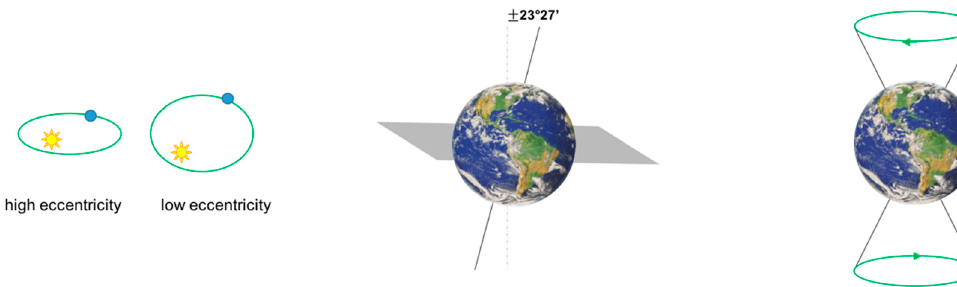
Figure 1. Temperature as a function of time during the last 5,500,000 years [31].